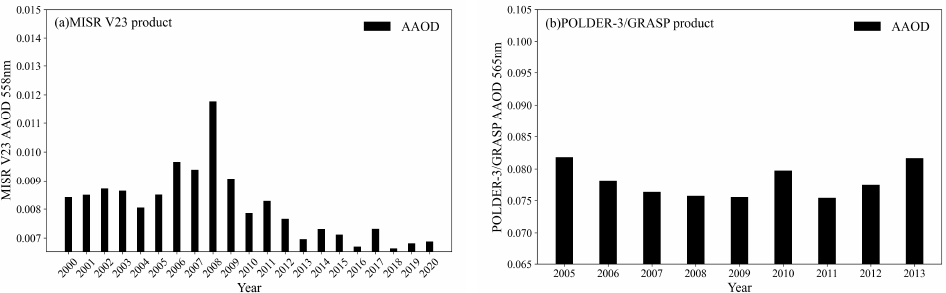
Figure 5. Variation figures of annual mean AAOD: ( a ) MISR V23 product; ( b ) POLDER-3/GRASP product.